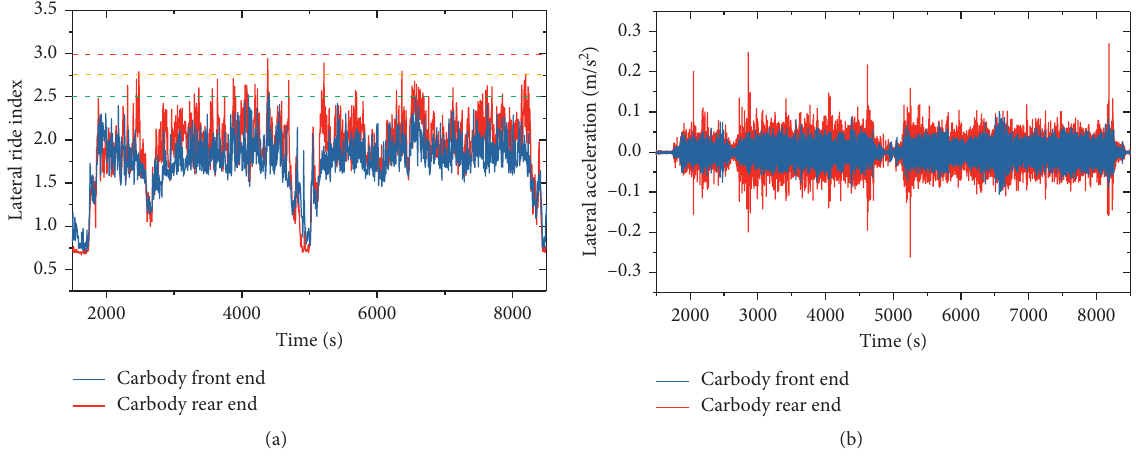
Figure 16: Carbody vibration with optimized wheel-rail contact. (a) Lateral ride index and (b) lateral